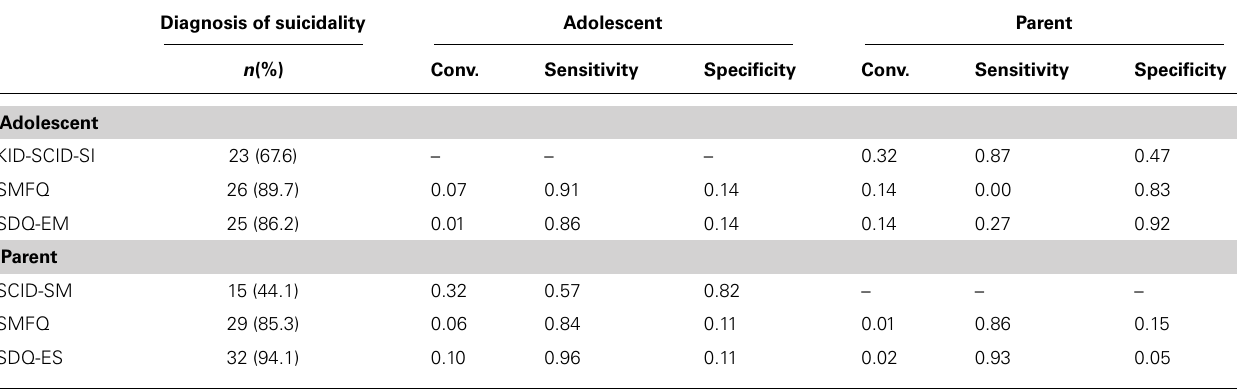
Table 2 | Diagnosis, convergence, sensitivity, and specificity scores using theAdolescent KID-SCID suicidality item or the parent KID-SCID suicidality item. Diagnosis of suicidality